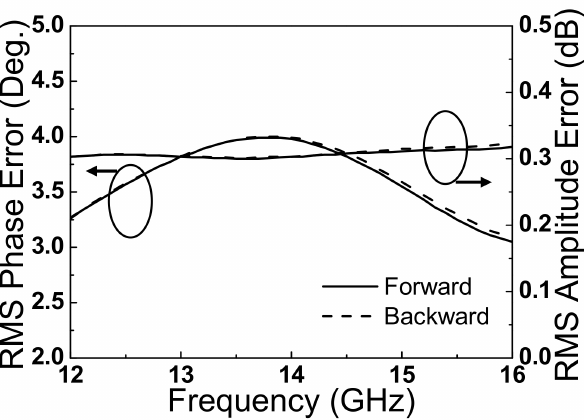
Figure 14. Measured root mean square phase and amplitude errors of the phase shifter.